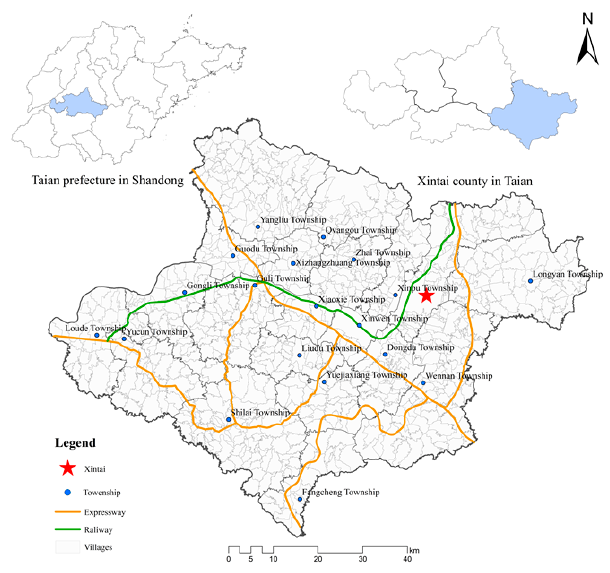
Figure 2. Geographical location of Xintai City, China.